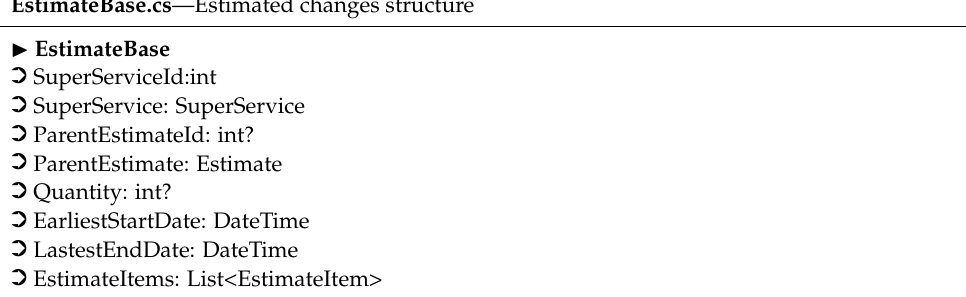
Algorithm 2: Database modification process in relation to the described models. Expansion of the database depends on the need to use the SuperService entity in order to calculate the estimates.